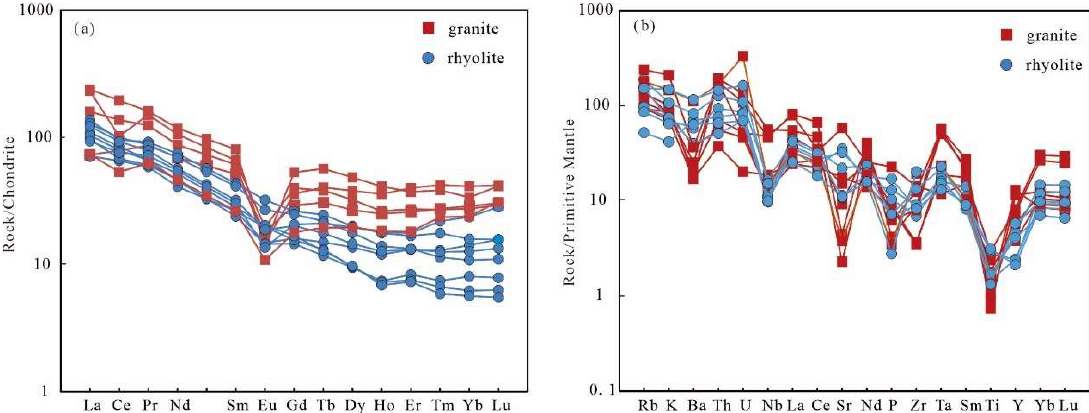
Figure 5. ( a ) The chondrite normalized REE pattens for the Early Cretaceous magmatic rock from the Badaguan area, modified from Boynton [32] and ( b ) the primitive mantle normalized trace element spider diagrams for the Early Cretaceous magmatic rock from the Badaguan area, modified from Sun and McDonough [33].